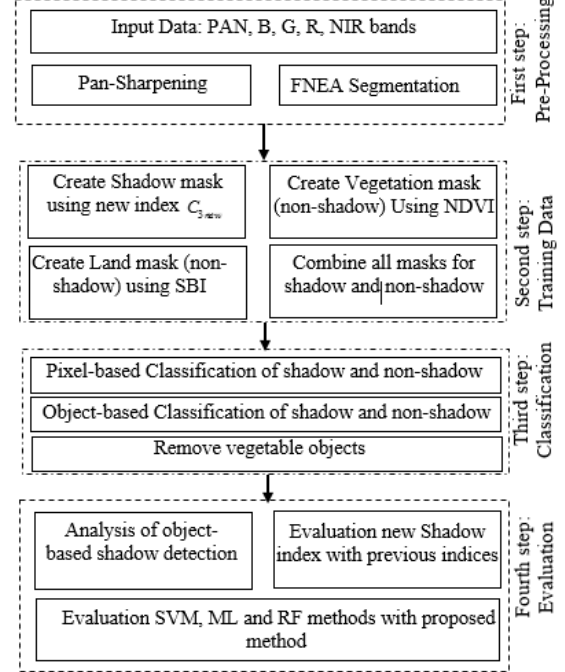
Figure 2. flowchart of proposed shadow detection method